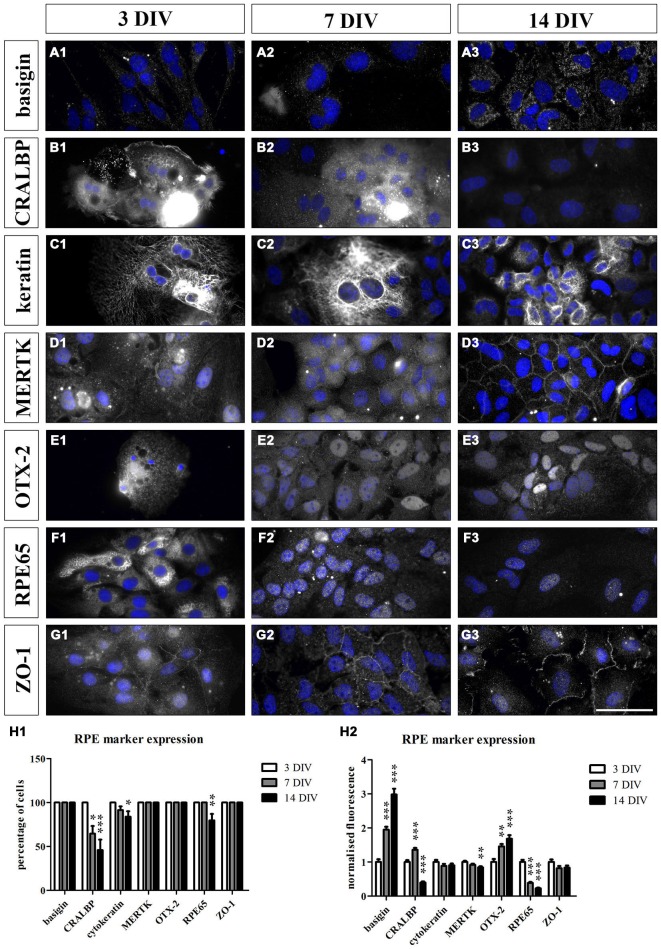
Cultured RPE cells expressed RPE-specific markers. We sparsely cultured 3000 fresh sprague dawley (SD) RPE cells per cm2 isolated using papain for 3, 7 and 14 days. We used immunostaining to evaluate whether the cultured cells lose their RPE-specific markers over time. At each timepoint, the cells were fixed with 4% PFA and stained for the respective cell markers (Table 2). Additionally, HOECHST was used to visualize cell nuclei (blue). We counted the number of cells that expressed the markers and compared the fluorescence intensity at all timepoints. (A1–G1 and H1) The RPE cells expressed all the markers at 3 DIV. (A1–A3 and H1–H2) Basigin was visible on the surface of the cells at all three timepoints and its expression increased during the culture period (H2). (B1–B3 and H1–H2) CRALBP was very prominent at 3 DIV (B1). However, fewer cells expressed the marker over time (H1) and its expression level decreased and was almost completely lost at 14 DIV (B3 and H2). (C1–C3 and H1–H2) Cytokeratin 18 was present in the RPE cells throughout the whole experiment. However, a small portion of the cells did not express this cytoskeletal marker at 7 and 14 DIV (H1). (D1–D3 and H1–H2) MERTK was expressed by the RPE cells at all three timepoints. The protein was especially prominent at the cell-cell contacts within the tight RPE cell monolayer that was formed at the end of the experiment (D3). However, the expression intensity decreased over time (H2). (E1–E3 and H1–H2) The transcription factor OTX-2 was visible within the cytoplasm as well as the nucleus of the RPE cells at all three timepoints. Moreover, its expression level increased during the culture period (H2). (F1–F3 and H1–H2) RPE65 was very prominent in the RPE cells at 3 DIV (F1) but its expression decreased during the experiment (H1 and H2). (G1–G3 and H1–H2) ZO-1 was visible at the margins of the hexagonally shaped RPE cells at all three timepoints. Scale bar = 50 μm.